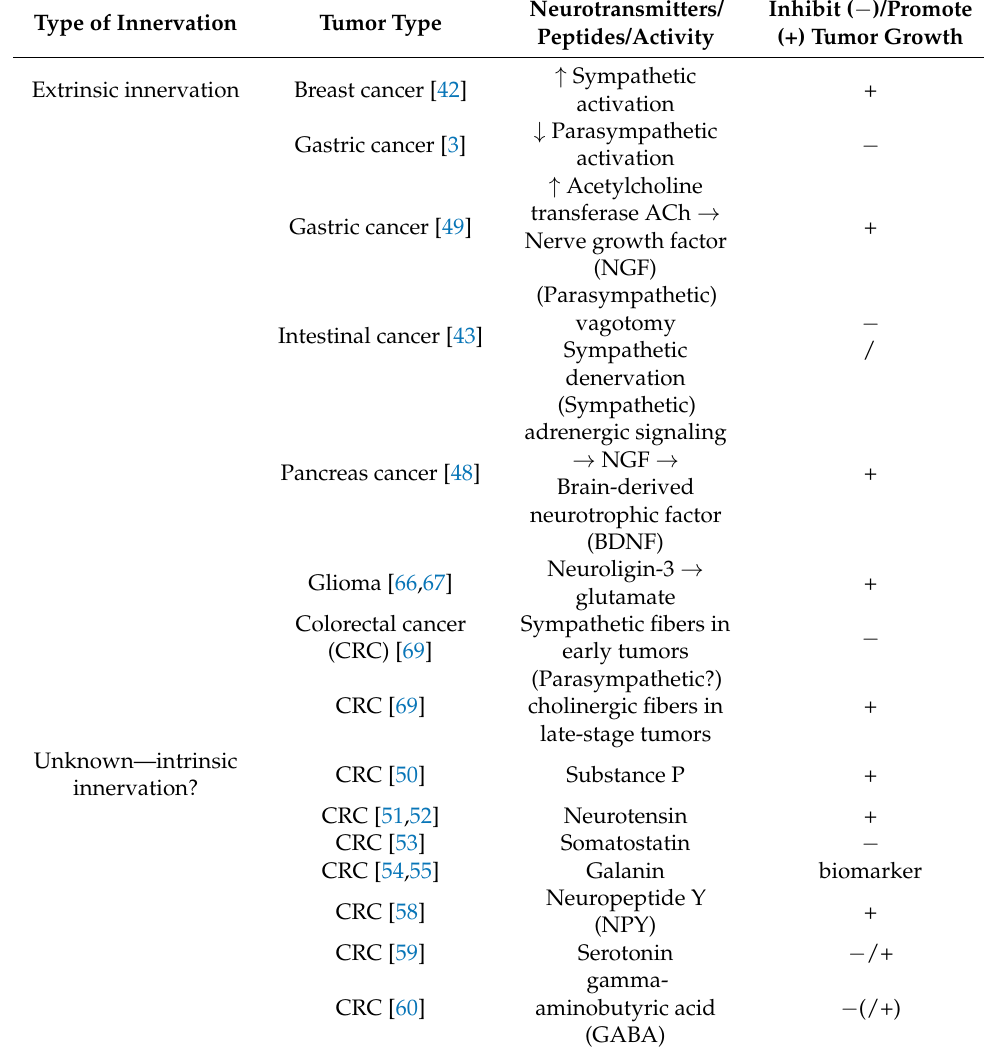
Table 1. The effect of the presence and activity of various nerves and neurotransmitters/peptides on different types of tumor